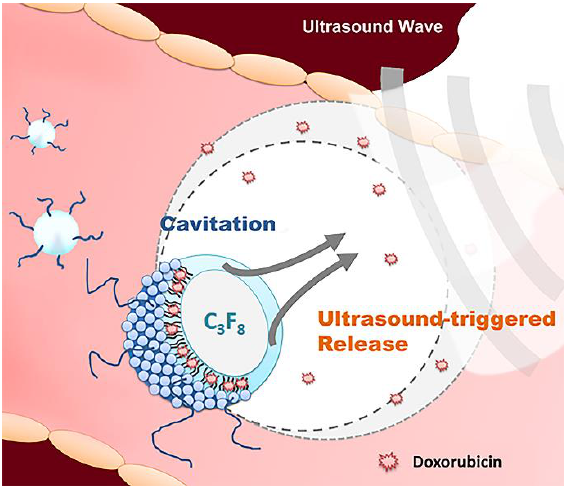
Figure 1. Diagram showing drug-loaded bubbles and ultrasound exposure to actively trigger drug release for osteosarcoma theranosis .